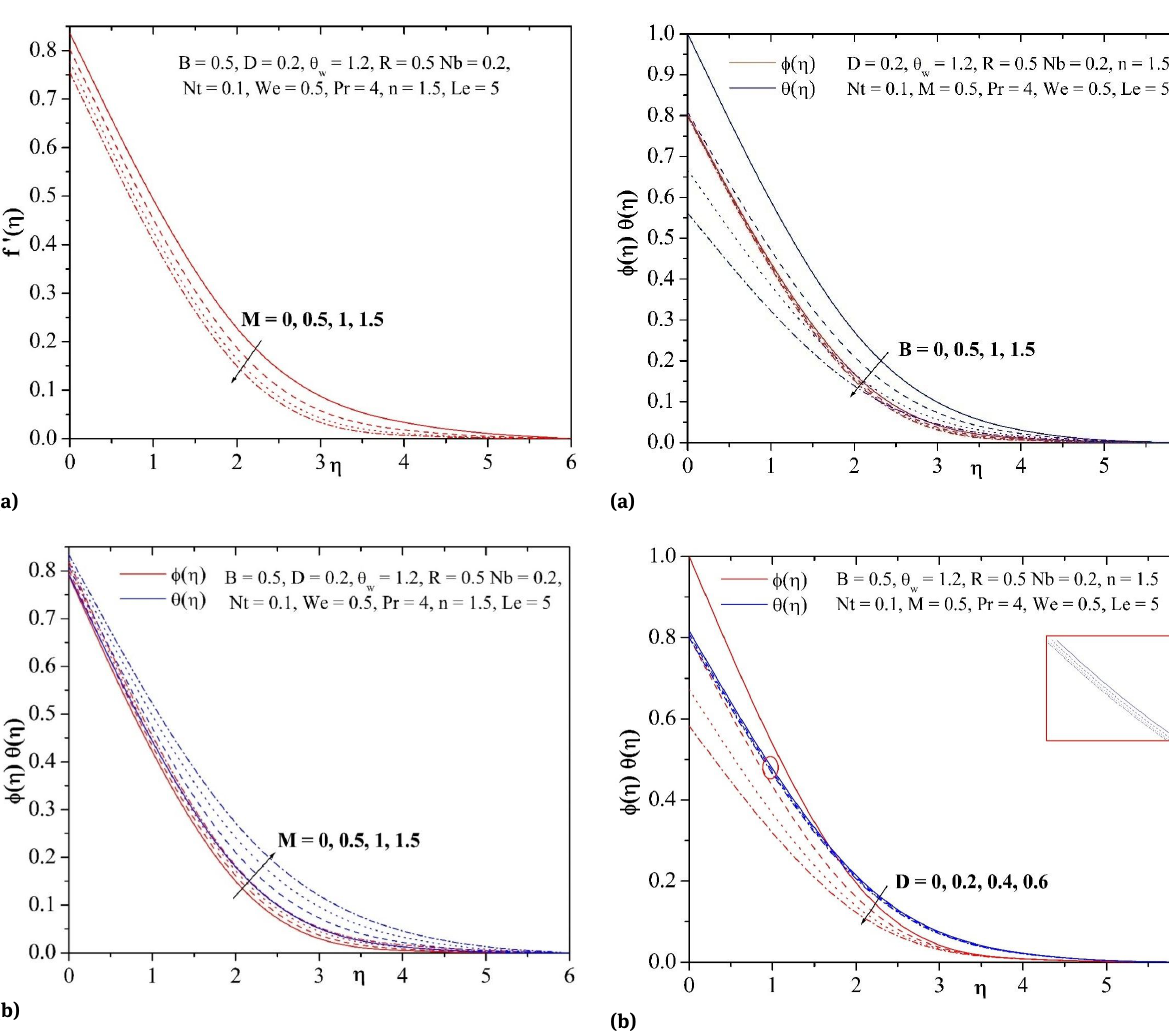
Fig. 5: (a) Influence of B on temperature and concentration profiles. (b) Influence of D on temperature and concentration